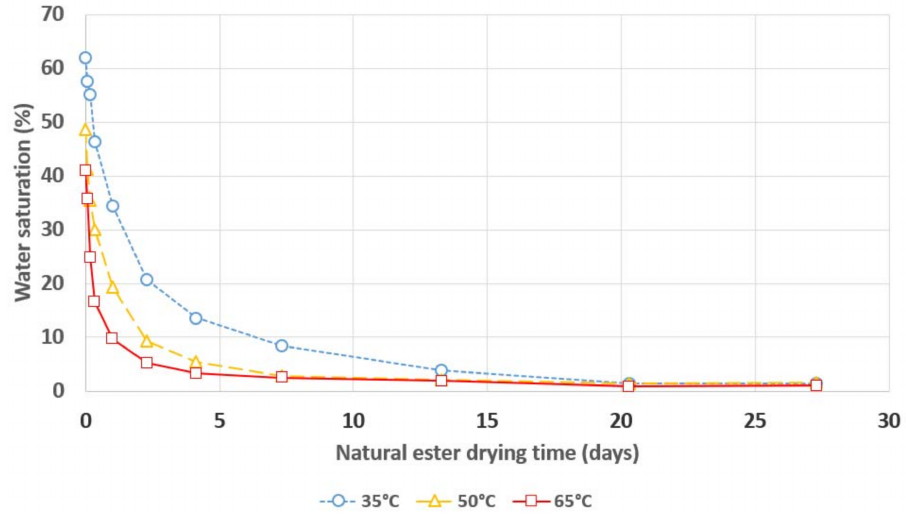
Figure 6. Relative saturation of water in natural ester during its drying with a 3A molecular